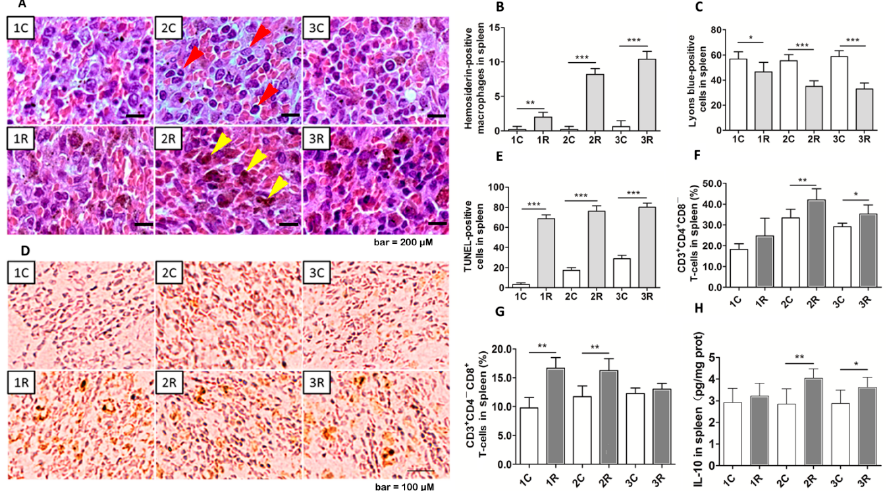
Figure 4. Apoptosis and distribution of T-cell subtypes in the spleen. ( A ) Hematoxylin and eosin staining of the spleen, red arrows indicate splenocytes with Lyons blue-stained nuclei and yellow arrows indicate reddish brown featured phagocytes (bar = 200 μ M); ( B ) Quantitative analysis of hemosiderin-positive phagocytes; ( C ) Quantitative analysis of Lyons blue-positive cells; ( D ) Apoptotic cells evaluated via terminal deoxynucleotidyl transferase dUTP nick end labeling (TUNEL) (bar = 100 μ M); ( E ) Quantitative analysis of TUNEL-positive cells; ( F ) Proportion of CD3 + CD4 + CD8 − T-cells; ( G ) Proportion of CD3 + CD4 − CD8 + T-cells; ( H ) Level of interleukin 10 (IL-10). All parameters were measured in the spleen. Representative photographs from three rats are presented in ( A , D ). ( F – H ) Each time point represents the results from seven rats. 1C, 2C, and 3C: control rats, one, two, and three months after mock irradiation, respectively. 1R, 2R, and 3R: irradiated rats, one, two, and three months after exposure, respectively. * p < 0.05, ** p < 0.01, *** p < 0.001.